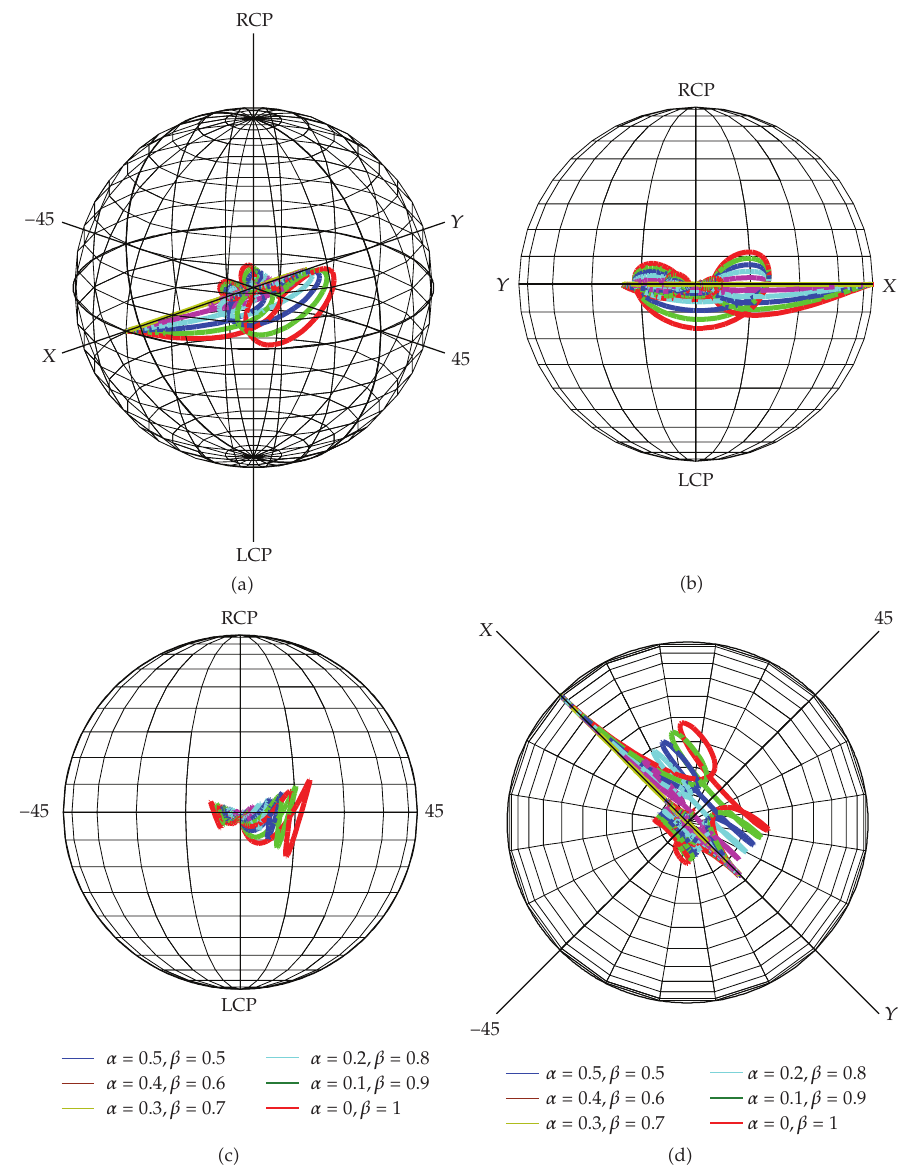
Figure 14: Photon polarization dynamics on the poincare sphere for small Δ